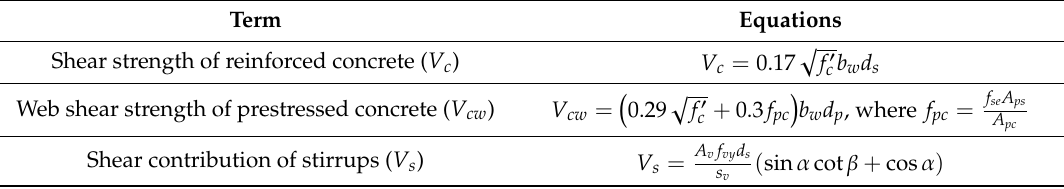
Table 3. Code equations for estimating shear strength